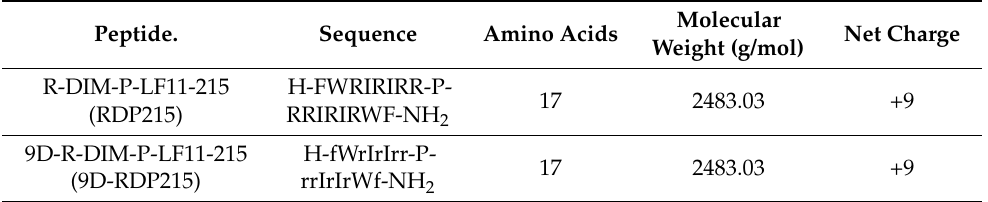
Table 1. Amino acid sequence, molecular weight and net charge of RDP215 and 9D-RD215. Lowercase letters represent D-amino acids. Peptide. Sequence Amino Acids